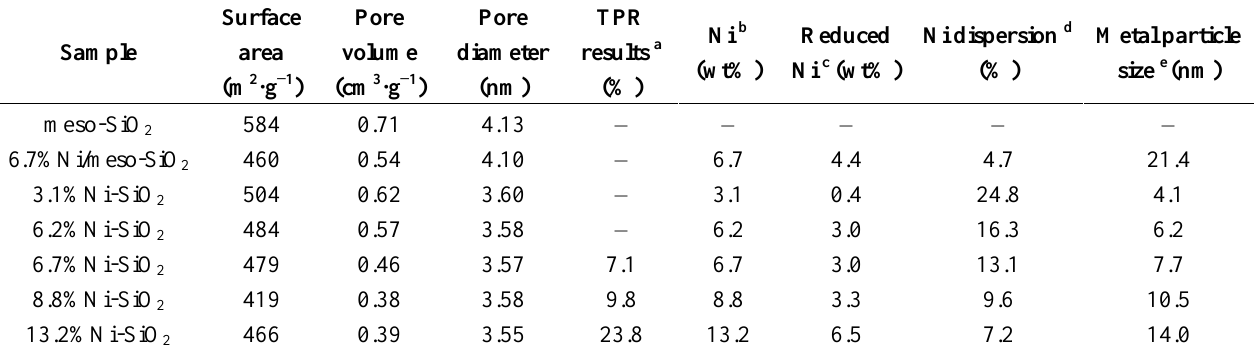
Table 1. Physiochemical properties of the meso-SiO TPR, temperature-programmed reduction.